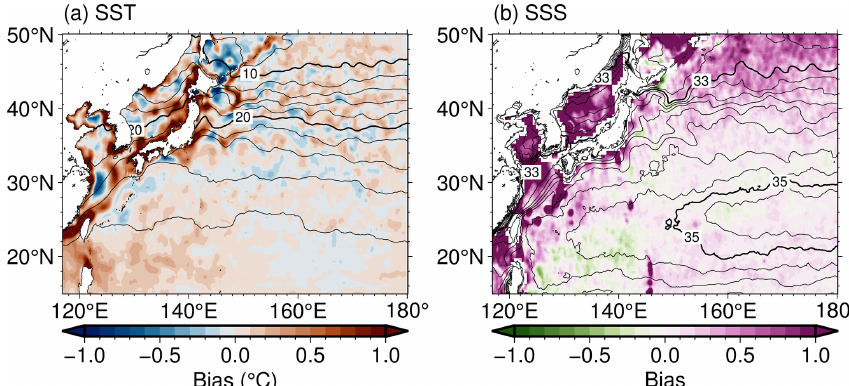
Figure 7. (a) SST and (b) SSS forecast biases (color) and averages (contours) over the whole experimental period in the AOEI run. Thin (thick) contour intervals are 2 (10) ◦ C in panel (a) and 0.25 (2) in panel (b) .